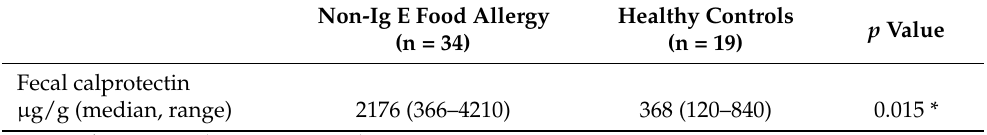
Table 3. Fecal calprotectin